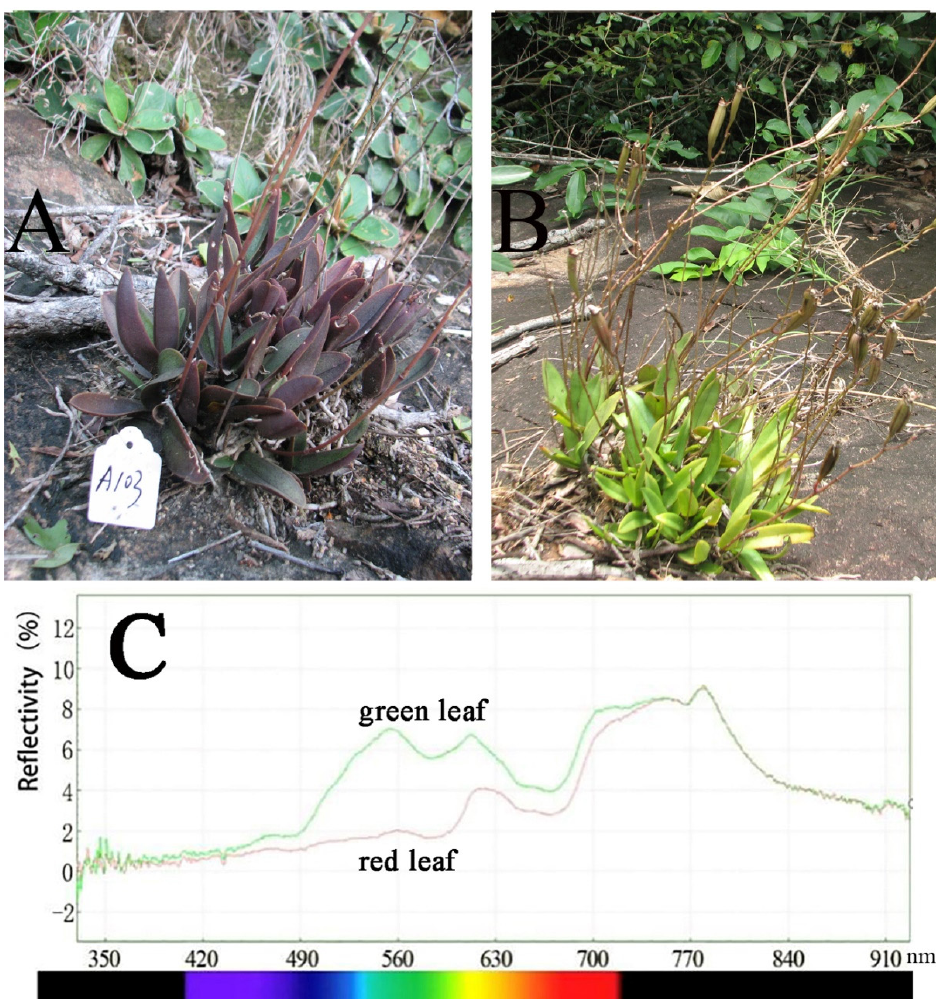
Figure 2. Field images of the red ( A ) and green ( B ) ecotypes; and their leaf reflection spectra ( C ).